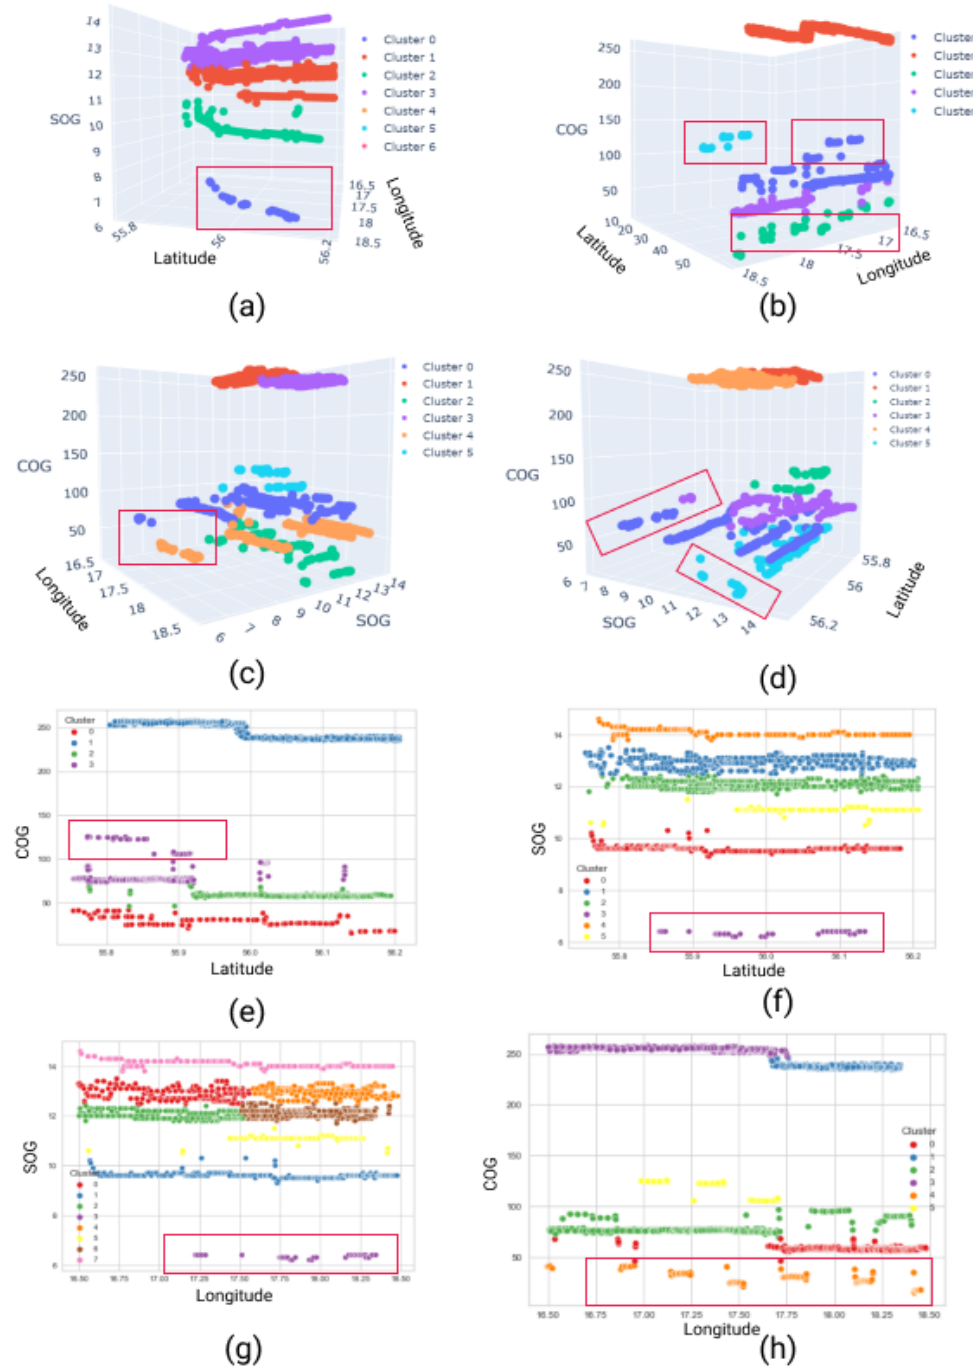
Figure 21. K-means results based on the various dimensional inputs ( a – h ). Red rectangles show some abnormal